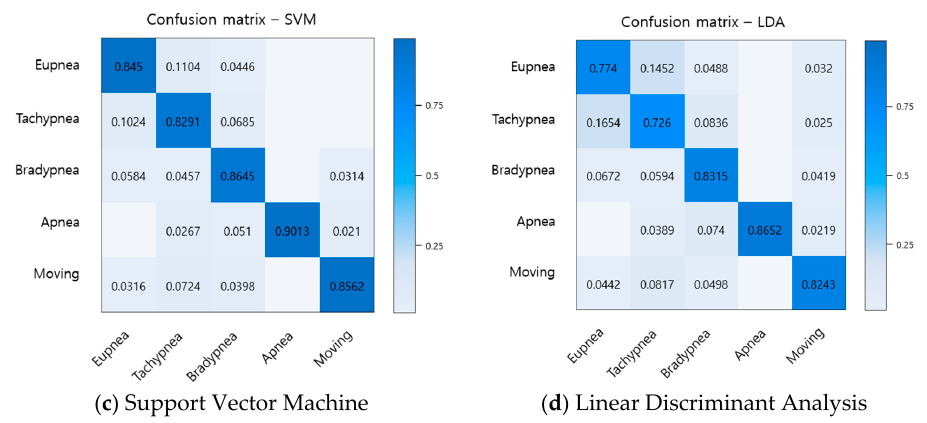
Figure 16. Comparison of recognition rate for breathing pattern among the proposed method and the traditional methods.